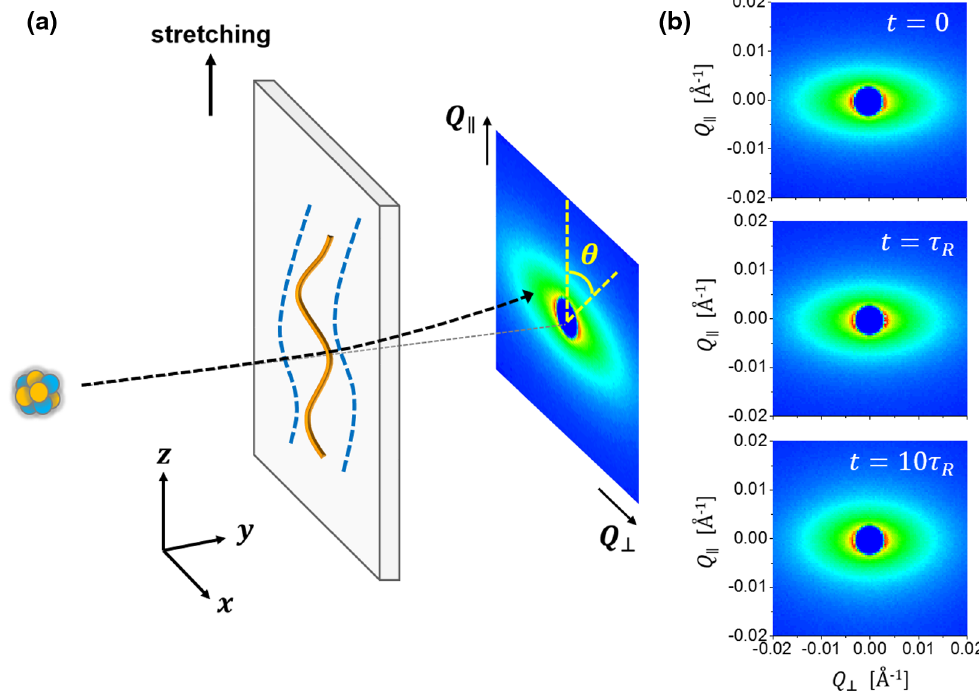
FIG. 1. (a) Illustration of SANS measurements on uniaxially elongated samples: the stretching is along the z axis, whereas the incident SANS beam is perpendicular to the xz plane. (b) Evolution of the SANS spectrum with polymer